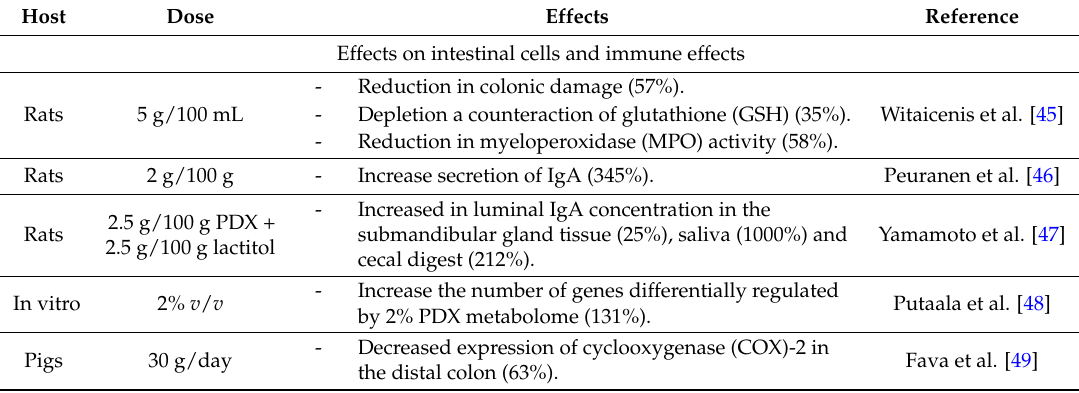
Table 3. The effects of administration of polydextrose on intestinal cells and immune